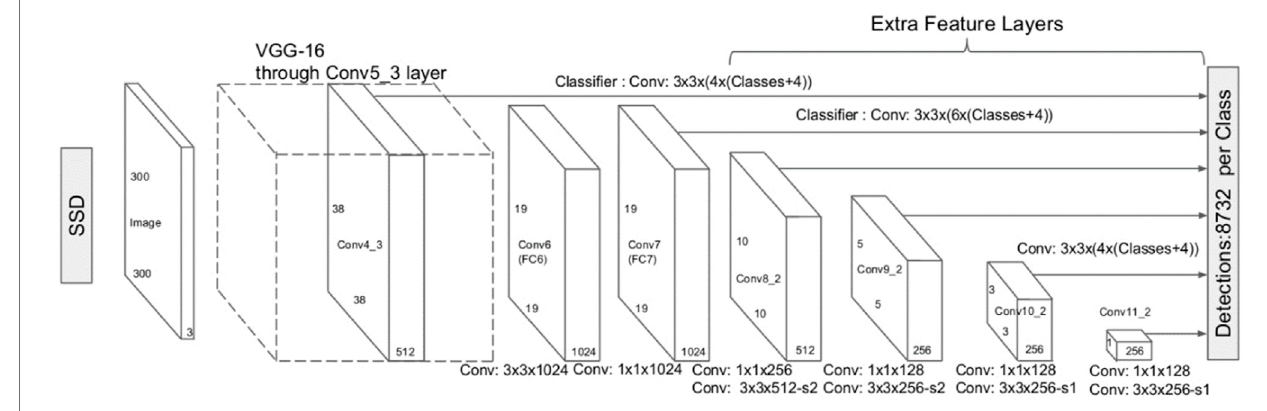
FIGURE 1 | SSD network structure.